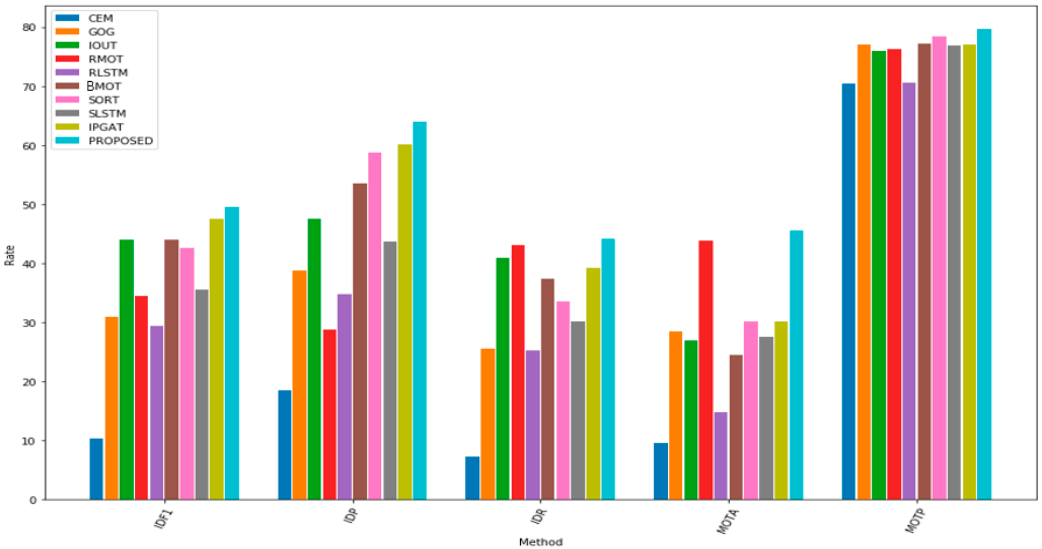
Figure 6. Comparative analysis of proposed method with existing methods. CEM: continuous energy minimization, GOG: global optimal greedy, IOUT: intersection-over-union tracker, RMOT: relative motion online tracking, RLSTM: relative long short term memory, Bayesian multi-object tracking (BMOT), SORT: simple online and real-time tracking, SLSTM: social long short-term memory.